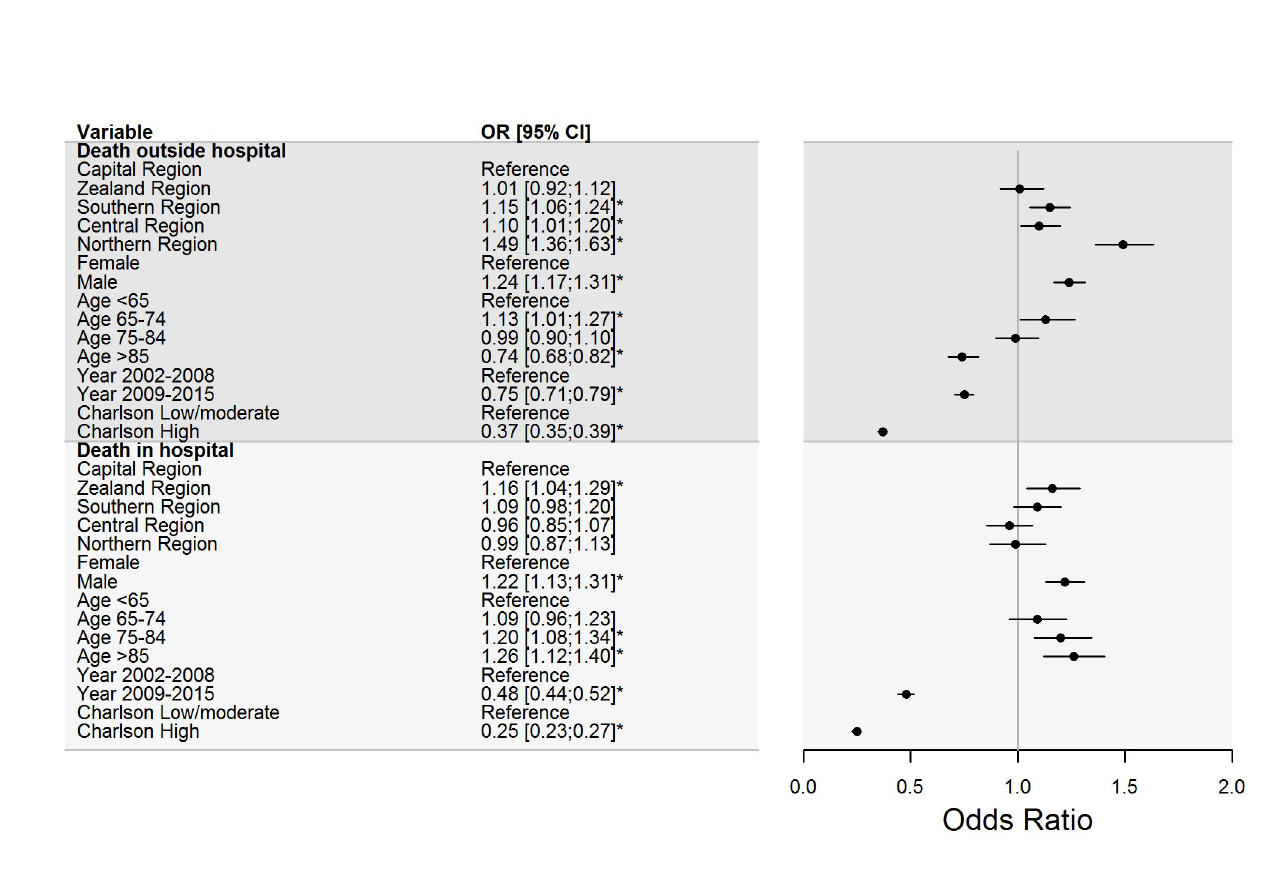
Fig 3. Risk of uncertain acute myocardial infarction across regions by place of death. Multivariable multinomial logistic regression model describing risk (odds ratios), with corresponding 95% confidence intervals, of Uncertain acute myocardial infarction (AMI) compared to all-cause mortality across official Danish regions, stratified by place of death. Model adjusted for covariates. The Reference in the model was the Capital Region of Denmark.